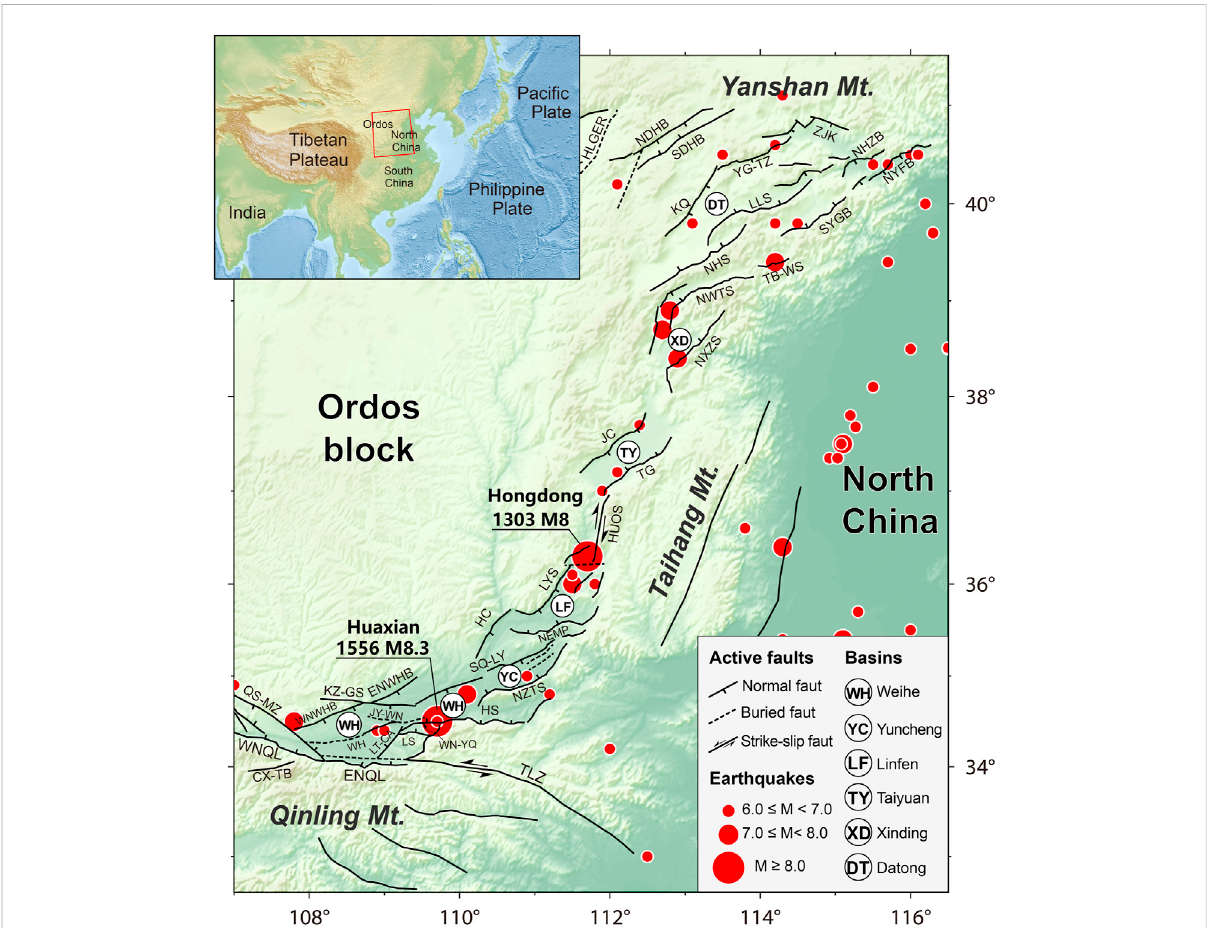
FIGURE 1 Distribution ofactivefaultsandstrongearthquakesintheFWRZ anditsadjacentregions.The faultdatamainlyrefertoDengetal. (2002)andXu et al. (2016). And the seismic data is cited from the National Earthquake Data Center (http://data.earthquake.cn). Fault abbreviations are CX-TB, the Chengxian-TaibaiFault;QS-MZ,theQishan-MazhaoFault;WNQL,theWesternsegmentofNorthQinlingFault;ENQL,theEasternsegmentofNorth Qinling Fault; HS, theHuashan Fault; NZTS, theNorth Zhongtiaoshan Fault; HC, theHanchengFault;TLZ,theTieluziFault; LT-CA,the Lintong- ChanganFault;WH,theWeiheFault;WN-YQ,theWeinan-YuanqianFault;JY-WN,theJingyang-WeinanFault;LS,theLishanFault;NEMP,theNorth Fault of Emei Platform; SQ-LY, the Shuangquan-Linyi Fault; KZ-GS, the Kouzhen-Guanshan Fault; WNWHB, the Western segment of North Weihe BasinFault;ENWHB,theEasternsegmentofNorthWeiheBasinFault;LYS,theLuoyunshan Fault;HUOS,theHuoshanFault;JC,theJiaochengFault; TG,theTaiguFault;NXZS,theNorthXizhoushanFault;NWTS,theNorthWutaishanFault;NHS,theNorthHengshanFault;LLS,theLiulengshanFault; KQ, The Kouquan Fault; YG-TZ, the Yanggao-Tianzhen Fault; ZJK, the Zhangjiakou Fault; NHZB, the North Huaizhuo Basin Fault; NYFB, the North Yangfan Basin Fault; SYGB, the South Yuguang Basin Fault; TB-WS, the Taibai-Weishan Fault; NDHB, the North Daihai Basin Fault; SDHB, the South Daihai Basin Fault; DQS, the Daqingshan Fault; HLGER, the Helinge ’ er